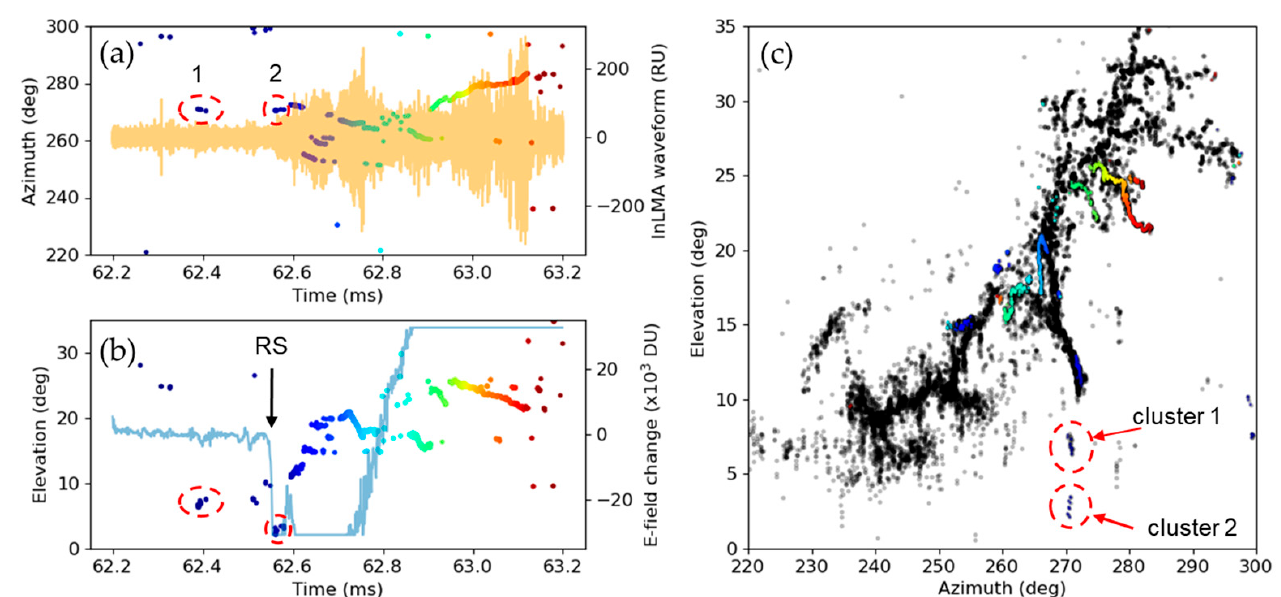
Figure 13. 2D mapping result of the discharge processes around the positive return stroke. ( a ) Azimuth and InLMA raw waveform; ( b ) Elevation and FALMA E-field change ( c ) 2D vertical view of elevation versus azimuth. Black points are all discharge sources occurring during the period from lightning initiation until 62.2 ms later; color points coded in time are the discharge sources during the period around the positive return stroke. Two clusters are circled with red dotted lines, with cluster 1 occurring before the return stroke, likely due to the downward positive leader of the stroke, while cluster 2 occurs at the initial stage of the return stroke.